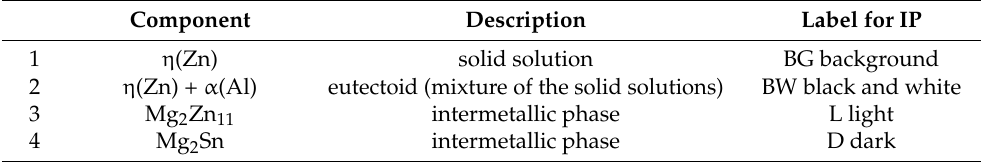
Table 4. Investigated phases and microstructural components.